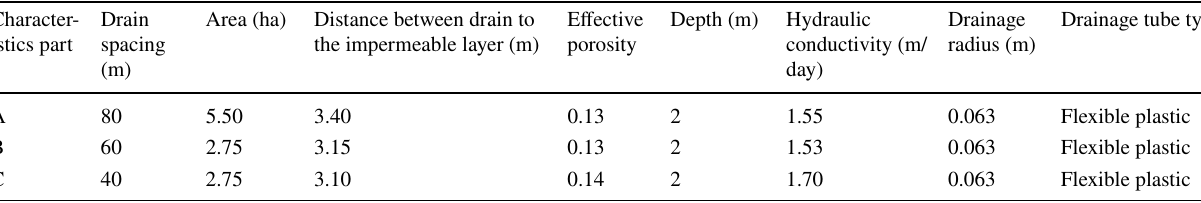
Table 1 Study area characteristics Character- istics